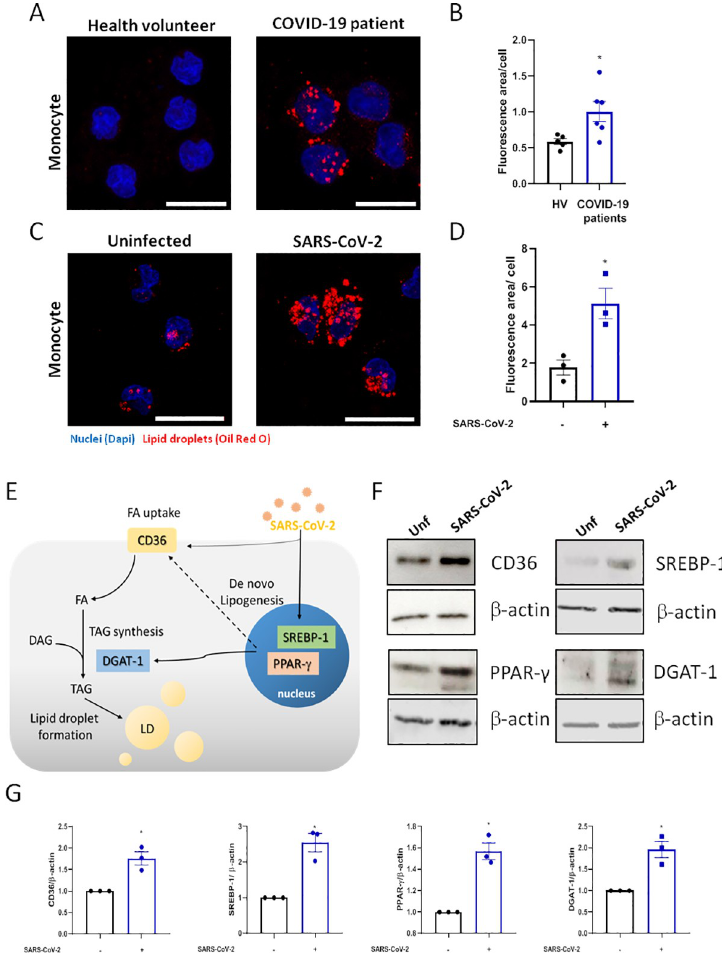
Fig 1. SARS-CoV-2 infection modulates the lipid metabolism in human monocytes. (A and C) LDs were captured by fluorescent microscopy after Oil Red O staining (Red) and nuclei stained with DAPI (Blue). (A) Representative images of monocytes from COVID-19 patients and health volunteers. (C) Representative images of human monocytes obtained from PBMC infected by SARS-CoV-2 with MOI of 0.01 for 24 hours. Scale bar 20 μ m. (B and D) LDs were evaluated by ImageJ software analysis by the measurement of the fluorescent area. (E) Representative scheme of the increase of proteins associated with lipid metabolism by SARS-CoV-2 infection in monocyte can regulate the lipid droplet formation. (F) Monocytes were infected by SARS-CoV-2 with MOI of 0.01 during 24h. Cell lysates were collected for the detection of CD36, PPAR- γ , SREBP-1, DGAT-1 by Western blotting. β -actin levels were used for control of protein loading. (G) Densitometric evaluation of data of panel 1F. Data are expressed as mean ± SEM of five healthy volunteers (HV) and six COVID-19 patients for ex vivo experiments and three healthy donors for LDs staining and western blot. � p < 0.05 versus health volunteers or uninfected